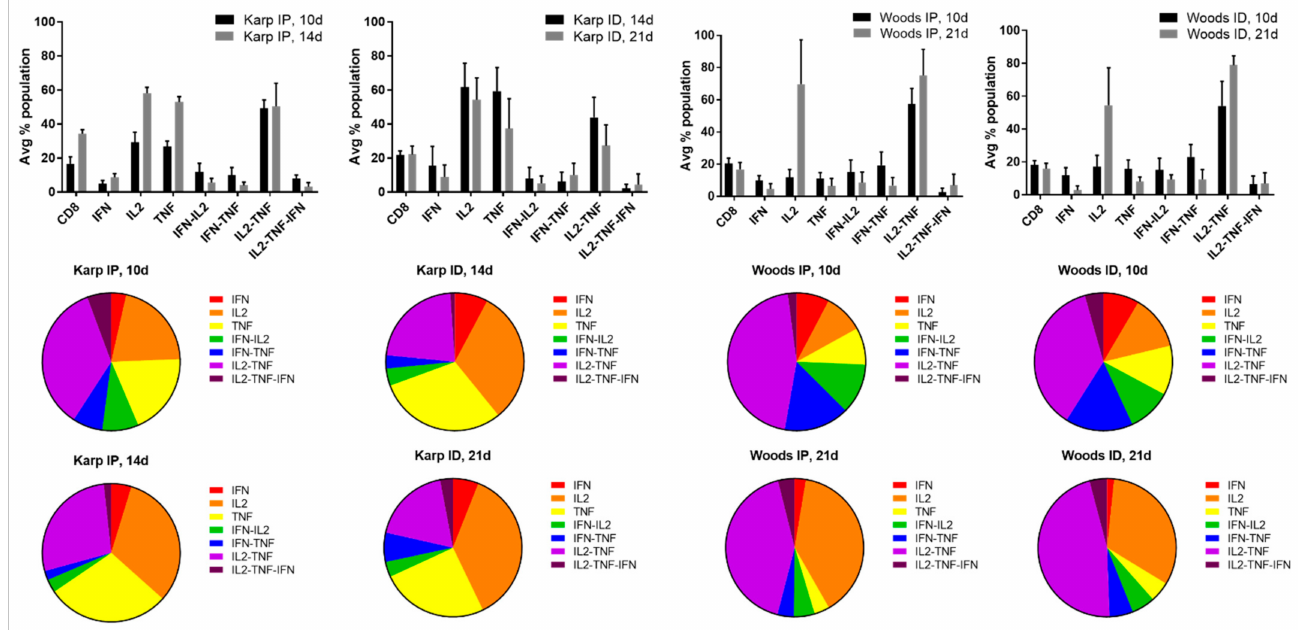
Figure 5. Multifunctional cytokine analysis of O. tsutsugamushi -specific CD8+ T cells represented by the frequency of cytokine (single, double, or triple) positive cells for the lethal (Karp IP) and nonlethal (Karp ID, Woods IP, and Woods ID) models of murine O. tsutsugamushi infection. The intracellular cytokine profiles for IFN, IL2, and TNF in individual cells were measured by multicolor flow cytometry with gating for CD4+ or CD8+ T cells. All possible combinations of cytokines are shown; the frequency of each population is shown as the